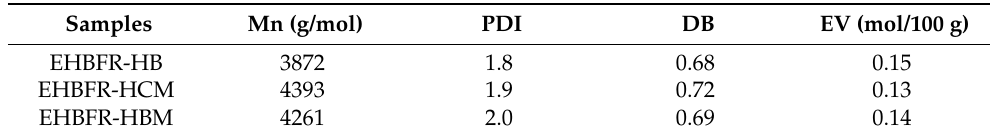
Table 2. Physical parameters of